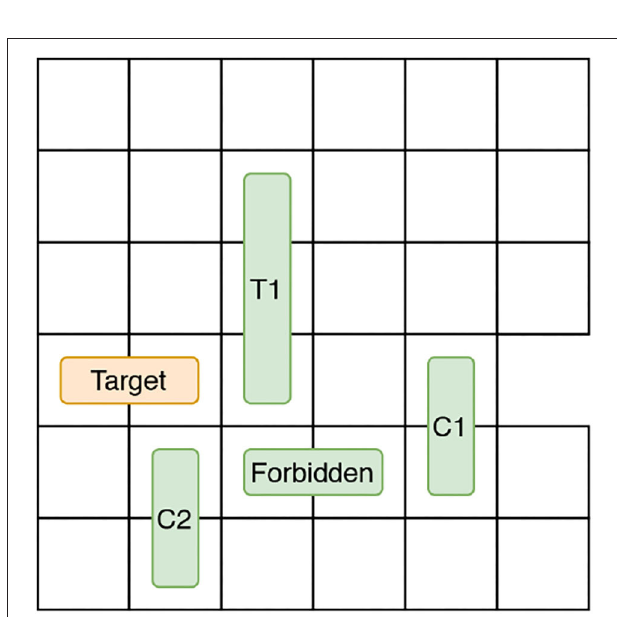
FIGURE 5 | Blocker